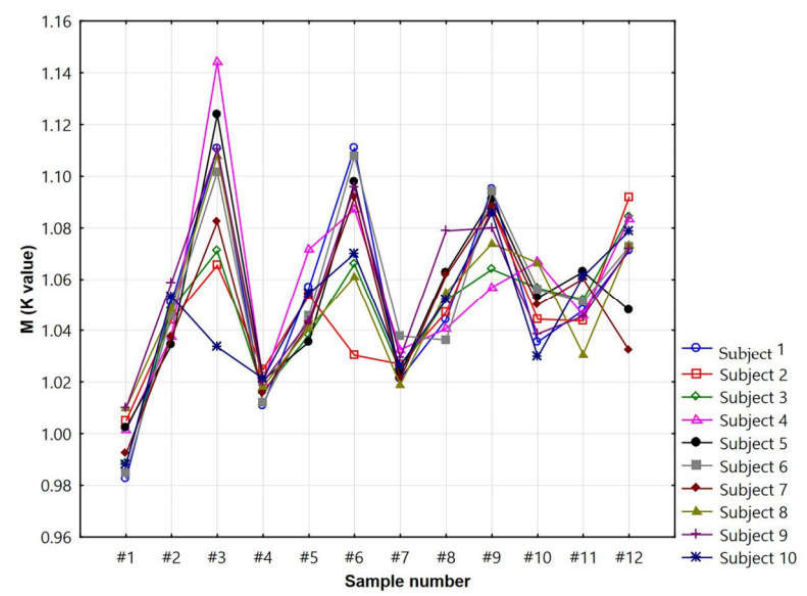
Figure 3. The blood flow promotion multiples of skin–blood microcirculation in the 12 pieces of seamless knitted fabric. Table 4 and Figure 3 showed that samples 1, 2, 4, 5, and 7 had low blood flow pro- motion multiples. The blood flow promotion multiples of samples 8, 10, 11, and 12 were lower. The blood flow promotion multiples of samples 3, 6, and 9 were higher. Among them, the blood flow promotion multiples of sample 3 were between 1.07 and 1.14. The blood flow promotion multiples of sample 6 were between 1.03 and 1.11. The blood flow promotion multiples of sample 9 were between 1.06 and 1.10. To obtain analysis results more accurately, the average results of 10 healthy females who were tested for blood flow promotion multiples were analyzed. This paper adopts the orthogonal experimental intu- itive analysis method to explore the relationship between the skin–blood microcirculation blood flow promotion multiples and the fabric structural parameters of 12 seamless knit- ted fabrics. The specific results are shown in Table 5. Table 5. Orthogonal analysis table of blood flow promotion multiples of skin–blood microcircula- tion.